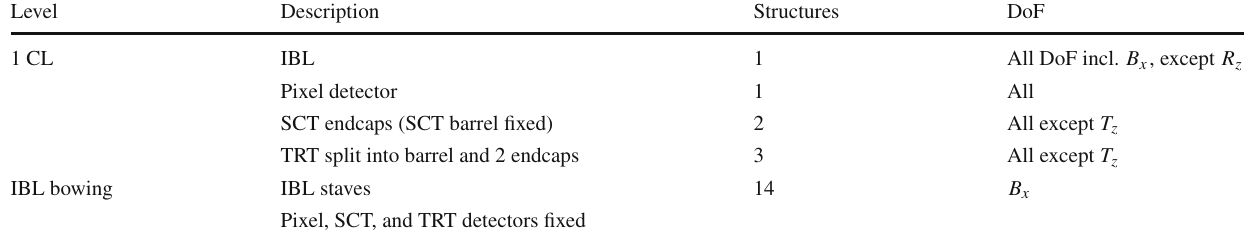
averaged over the 14 IBL staves relative to the baseline alignment (blue full circles) and the geometry after dynamic alignment (red open circles) with its statistical uncertainty.